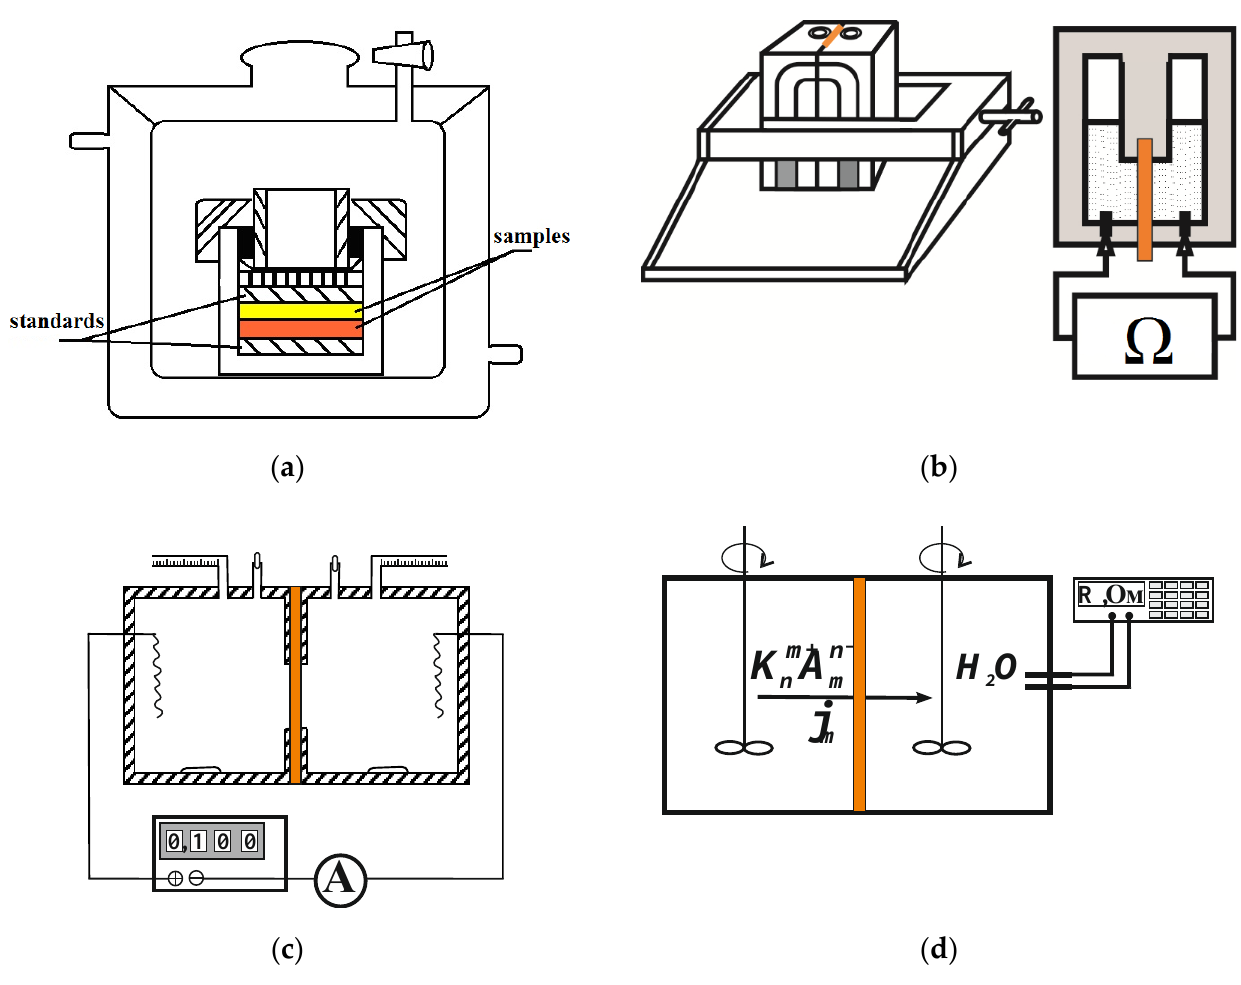
Figure 1. Schematic drawings of the experimental cells to determine porosimetric curve ( a ), conduc- tivity ( b ), electroosmotic ( c ) and diffusion ( d ) permeabilities of the membrane. The lower limit of integration is estimated as 1 nm, which corresponds to the lowest limit of this method applicability. The area of internal specific micropore surface ( S 2 ) with a radius less than 1 nm was approximately evaluated by the formula,